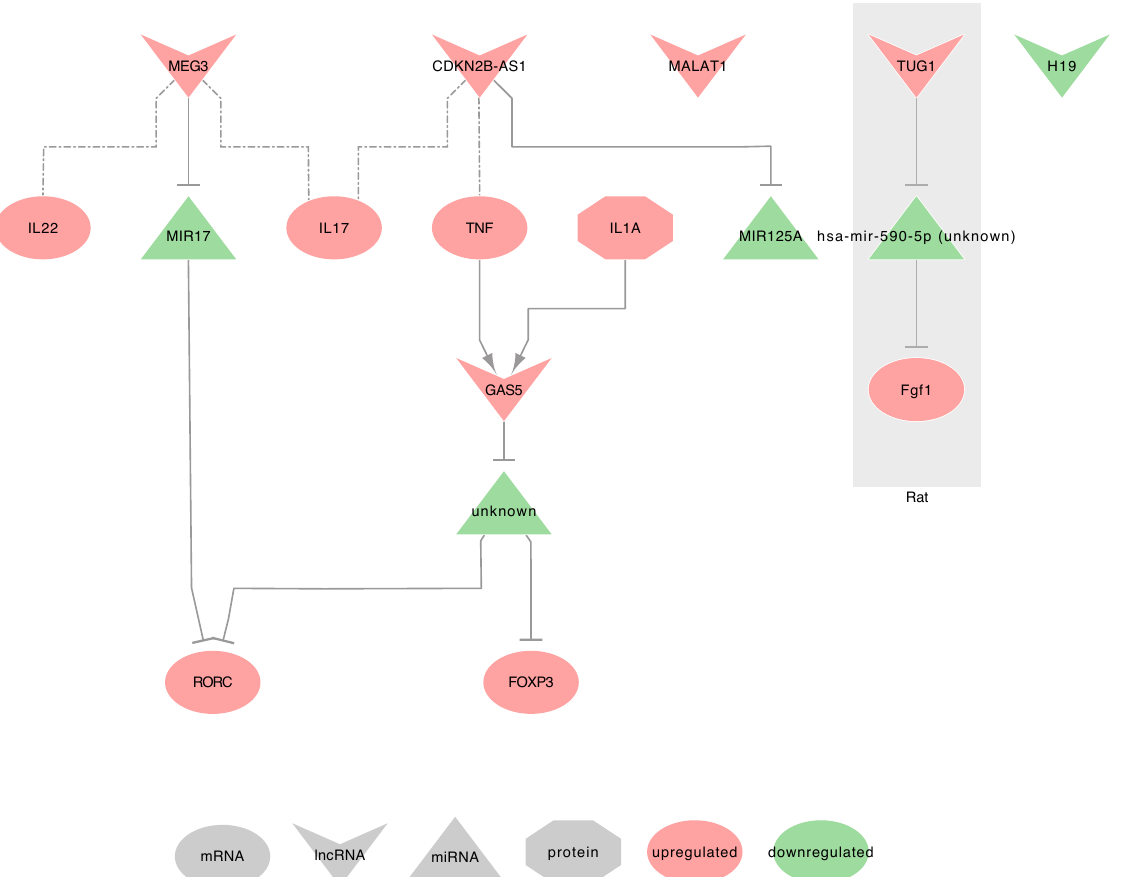
Figure 3. The selected eight lncRNAs in Asthma: A network of lncRNA-miRNA-Protein interactions. Upregulated molecules are in green. Downregulated molecules are in red. Up or down-regulated molecules are in purple. Shape definitions are in grey. Gray arrows target the activated molecules. T-ended lines target the inhibited molecules. Square-ended lines represent a binding between molecules. Dashed-dot lines represent an association with unknown